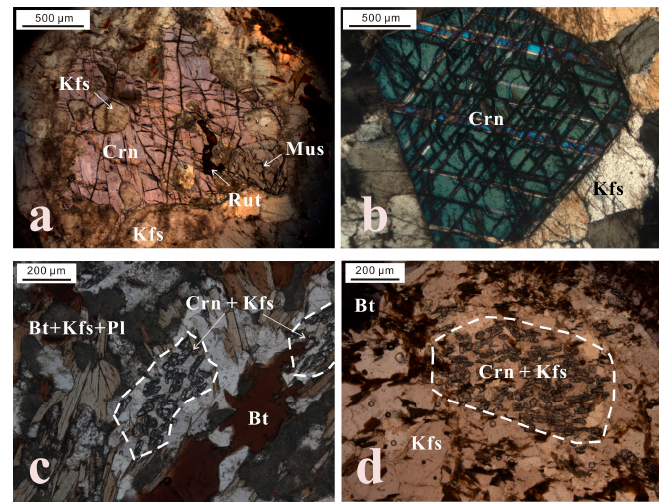
Figure 4. Representative photomicrographs of samples 1509GB and 1512MZT6 viewed in: PPL, plane-polarized light; XPL, crossed-polarized light. ( a ) Large corundum porphyroblast surrounded by K-feldspar and including relic muscovite (sample 1509GB; PPL). ( b ) Euhedral corundum porphyroblast in a coarse-grained aggregate of alkali feldspar in the leucosome (sample 1512MZT6; XPL). ( c , d ) Clusters of oriented grains of corundum intergrown with K-feldspar occurring in the mesosome domain ( c : sample 1509GB; d : sample 1512MZT6; PPL).